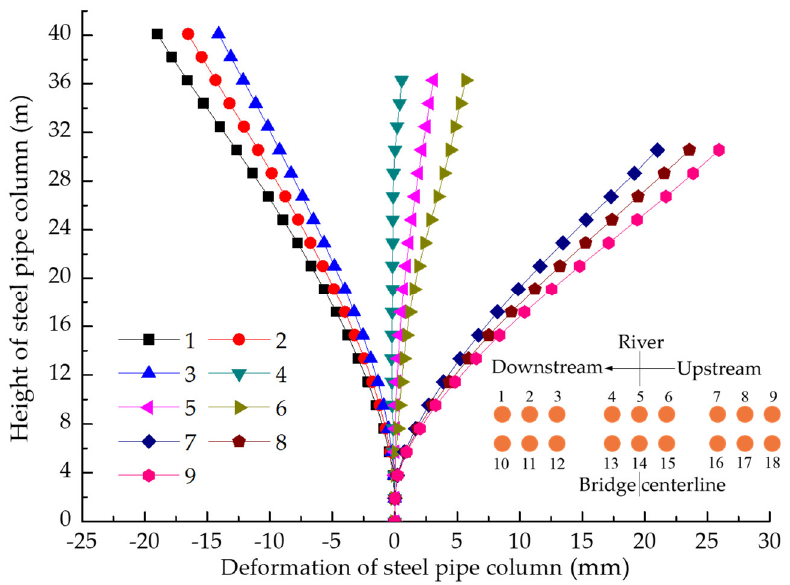
Figure 18. Deformation of the steel pipe columns along the longitudinal direction of the bridge.